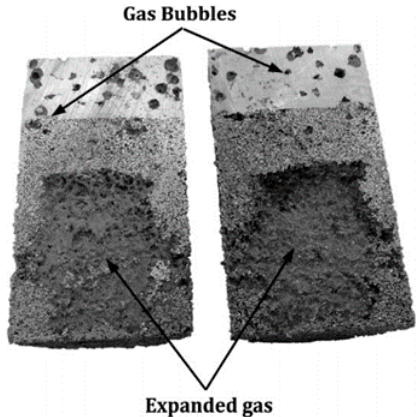
Figure 6. Defects caused by gas bubble expansion at a section of a magnesium foam that was depressurized before solidification. Reprinted from Reference [39] with permission from Wiley Online Library.